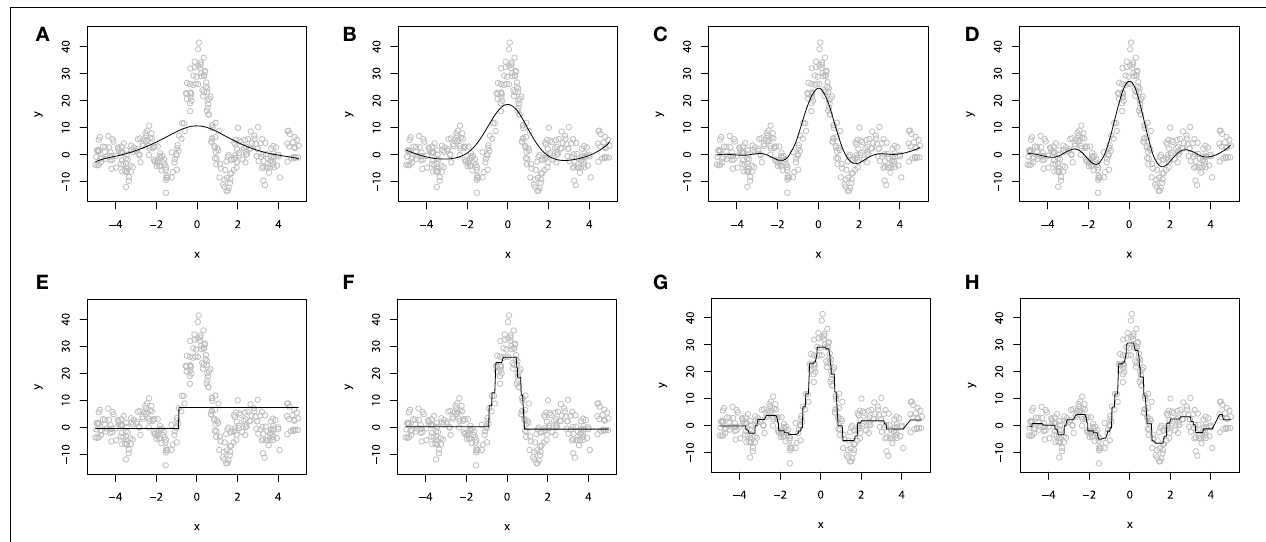
FIGURE 3 | P-Spline GBM model for different numbers of boosts: (A) M = 1; (B) M = 10; (C) M = 50; (D) M = 100. Decision-tree based GBM model for different numbers of boosts: (E) M = 1; (F) M = 10; (G) M = 50; (H) M = 100.